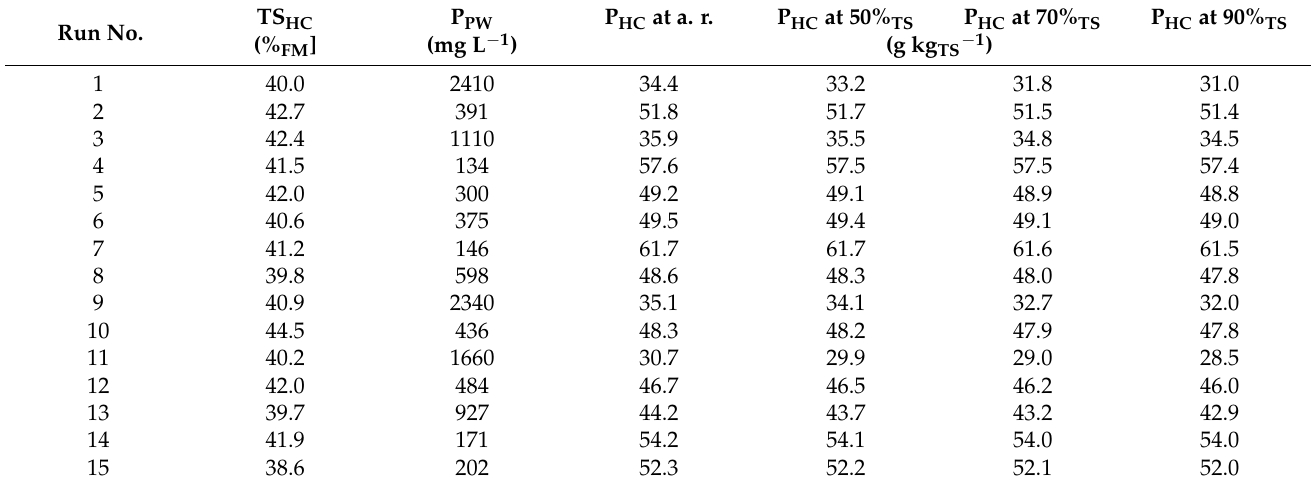
Table 3. Theoretical phosphorus concentrations of hydrochar at a given degree of